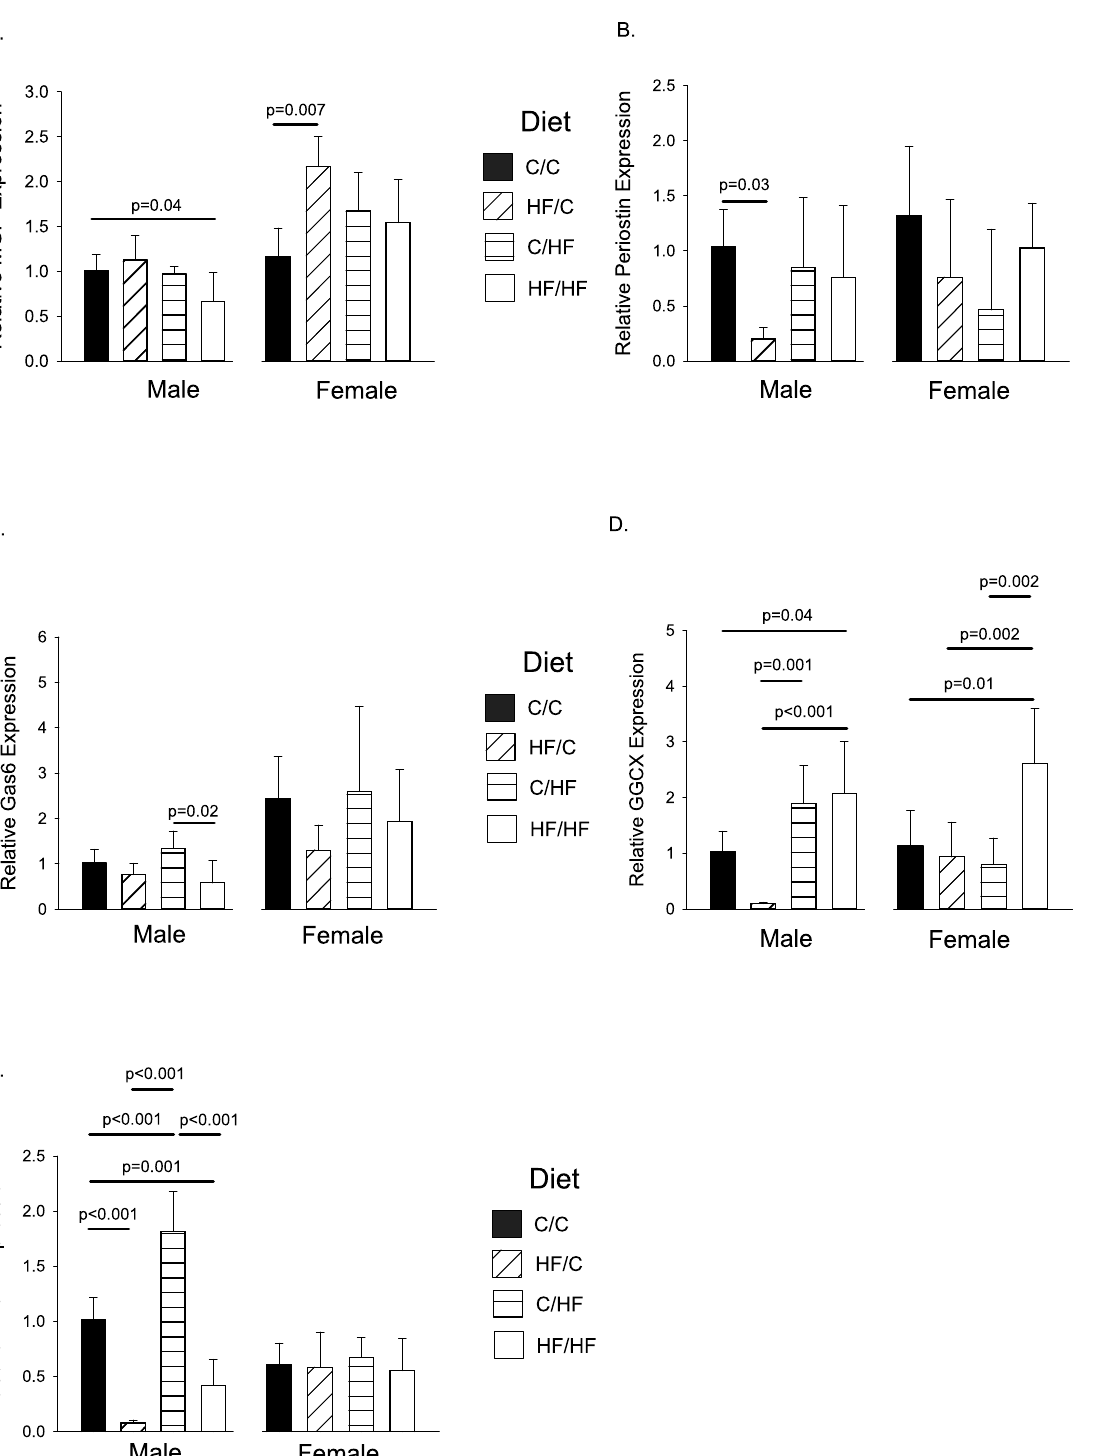
Fig 4. Mean Relative Gene Expression Levels in Aorta for Thirty Week Old Mice. Gene expression was determined by qPCR. Graphs show gene expression for (A). MGP , (B). Periostin , (C). Gas6 , (D). Ggcx , and (E). Vkor . Gene expression is shown relative to male C/C group. For all groups, n = 5 – 7 per group. Graphs show mean plus 95% confidence